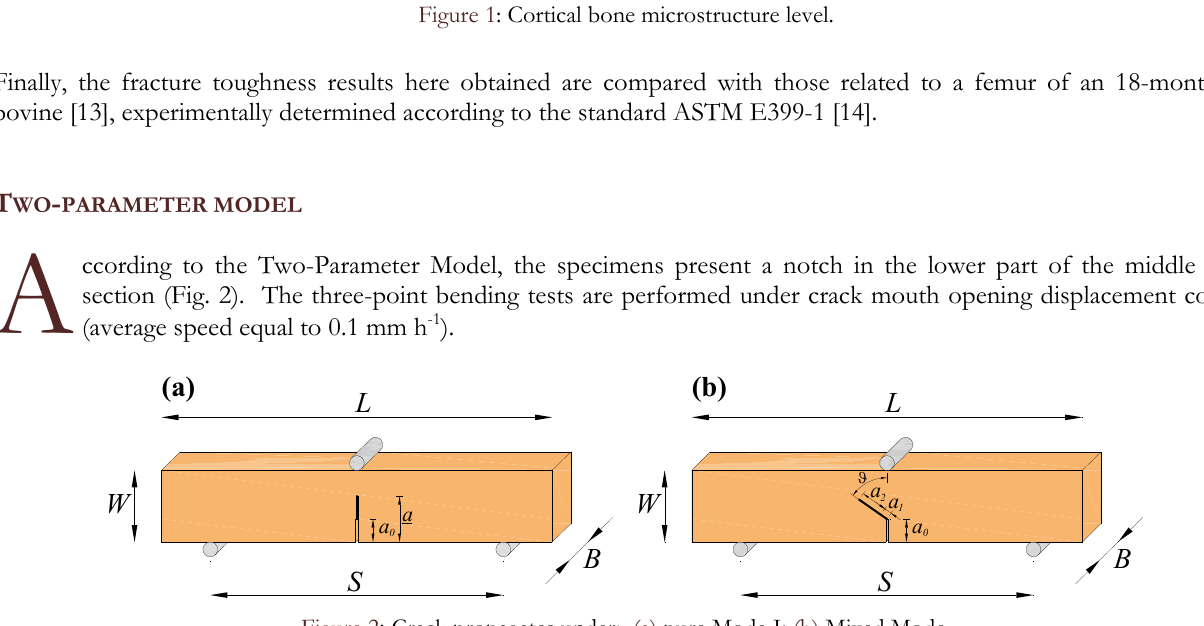
Figure 2 : Crack propagates under: (a) pure Mode I; (b) Mixed